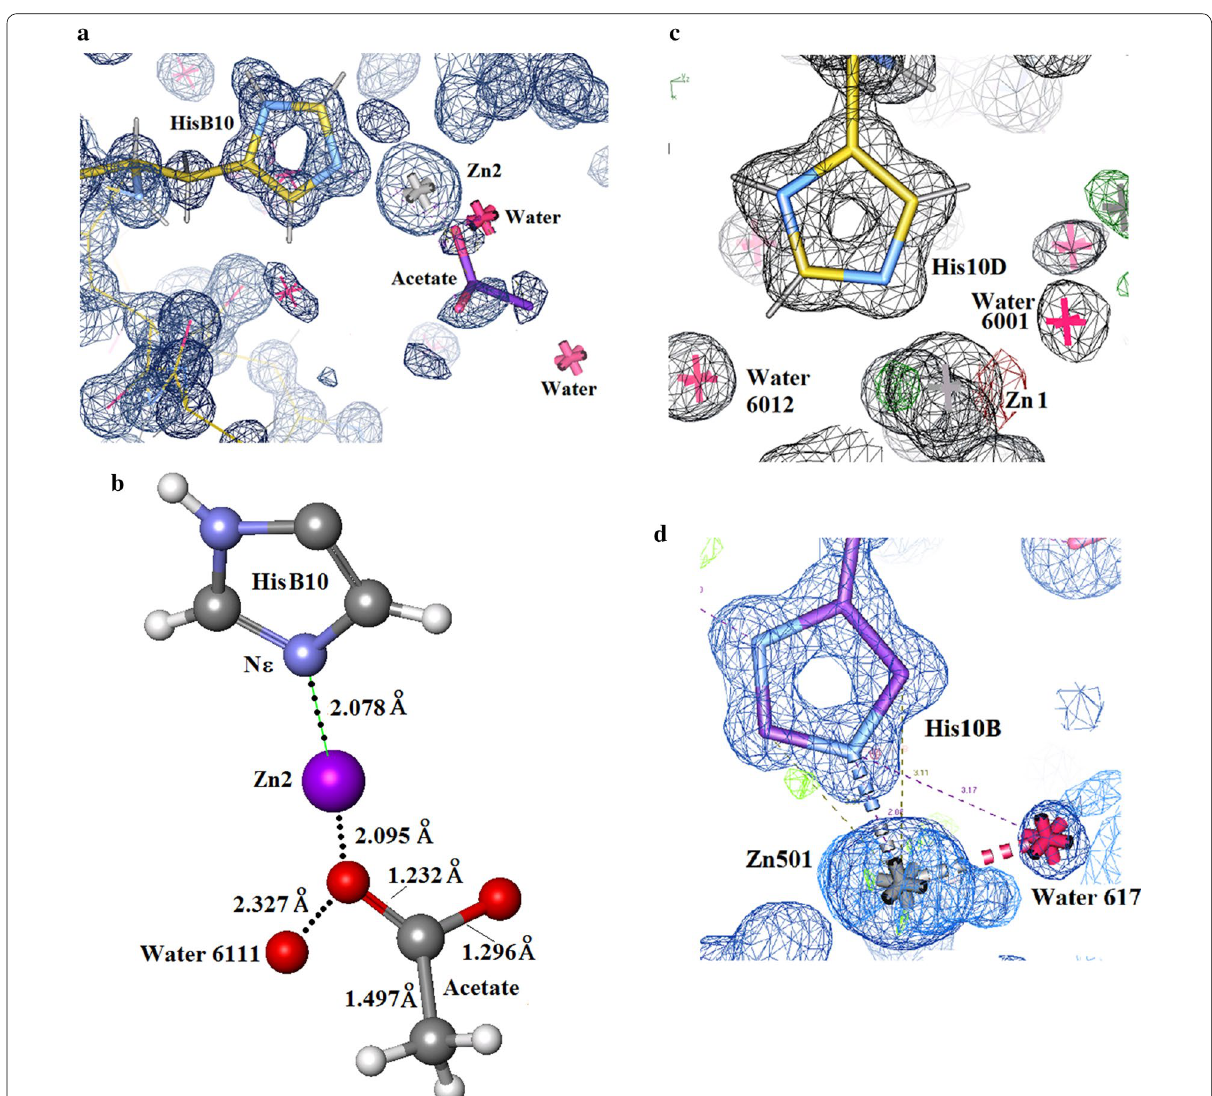
Fig. 19 a Insugen (I) electron density in the vicinity of Zn2100 (Zn2) in molecule 1: an acetate molecule acetate 2101 has been modelled in this site close to HisB10 in chain B. Drawn with WinCoot 0.7 [19]. b The Zn site in molecule 1 of Insugen (I). Zn2 is coordinated to His B10 Nε in chain B as usually observed in insulin structures (e.g Baker et al. [1]) and unexpectedly to a highly ordered acetate molecule acetate2101. Drawn with Accelrys Discovery Studio 3 [23]. c Insugen (I) structure electron density showing the vicinity of Zn4100 (Zn1) and HisD10 in chain D. Unlike chain B there is no acetate in this site. Two water molecules have been located whose equivalents are not present in the vicinity of Zn2100 (Zn2) which has the substituted acetate2101. Drawn with WinCoot 0.7 [19]. d Intergen (II) electron density in the vicinity of Zn501 in molecule 1 B‑chain. Both HisB10 Nε and water 617 coordinate Zn501. Water617 is the only coordinating water. There is no acetate molecule in this site. The same applies to site D. Drawn with WinCoot 0.7